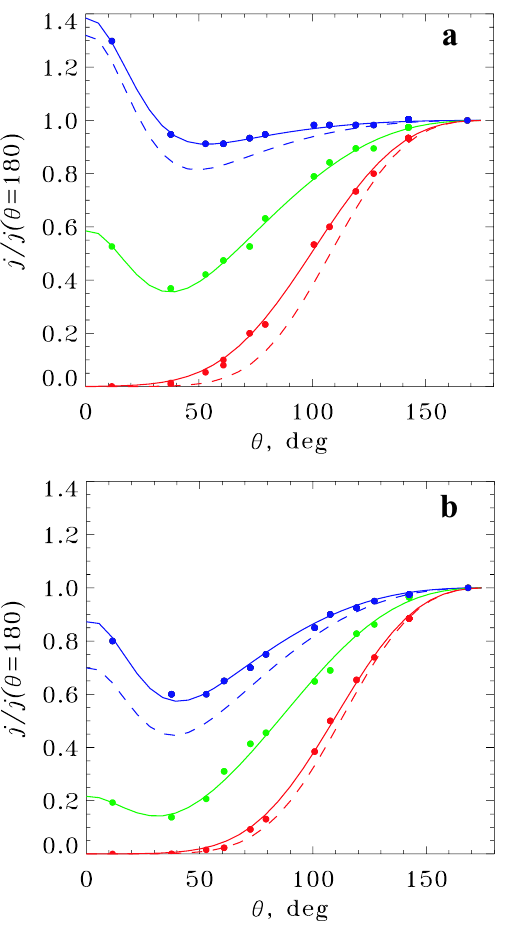
Fig. 11. Current angular distribution in an H + plasma with V 0 = V Ti (blue), V 0 =1.3 V Ti (blue dashed), V 0 =2 V Ti (green) and in an O + plasma with V 0 =4 V Ti (red), V 0 =5.2 V Ti (red dashed). Dots indi- cate computed values, solid lines represent their fits. Currents are normalized to their values for θ =180 ◦ . Plasma and probe char- acteristics are the same as in Fig. 2 and (a) ϕ =− 20 kT/e , (b) ϕ =− 10 kT/e